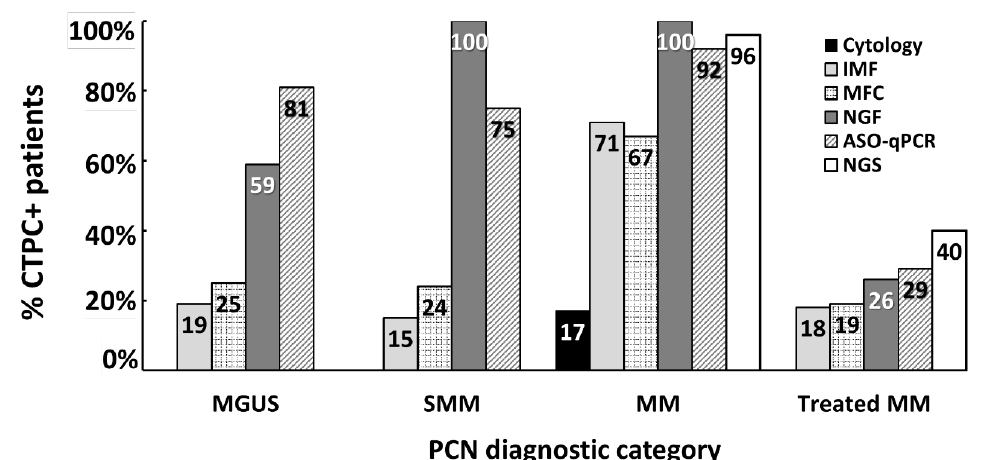
Figure 2. Frequency of newly-diagnosed PCN and treated MM patients with detectable CTPC in blood as assessed by distinct methods. ASO-qPCR, allele-specific oligonucleotide quantitative real-time polymerase chain reaction; CTPC, circulating tumor plasma cells; IMF, immunofluorescence microscopy; MFC, multiparameter flow cytometry; MM, multiple myeloma; NGS, next generation sequencing; MGUS, monoclonal gammopathy of undetermined significance; NGF, next generation flow; PCN, plasma cell neoplasm; SMM, smoldering MM. Data summarized from the following references in the literature [19,21–23,25,26,30,35,113–117]. Table 2. Advantages and disadvantages of the most frequently used methods for detection of circulating tumor plasma cells in patients diagnosed with plasma cell neoplasms. Cytology IMF MFC NGF ASO-qPCR NGS Availability High Low High High Intermediate Limited Applicability ≈ 100% ≈ 100% ≈ 100% ≈ 100% 42% to75% 80–90% Cytology